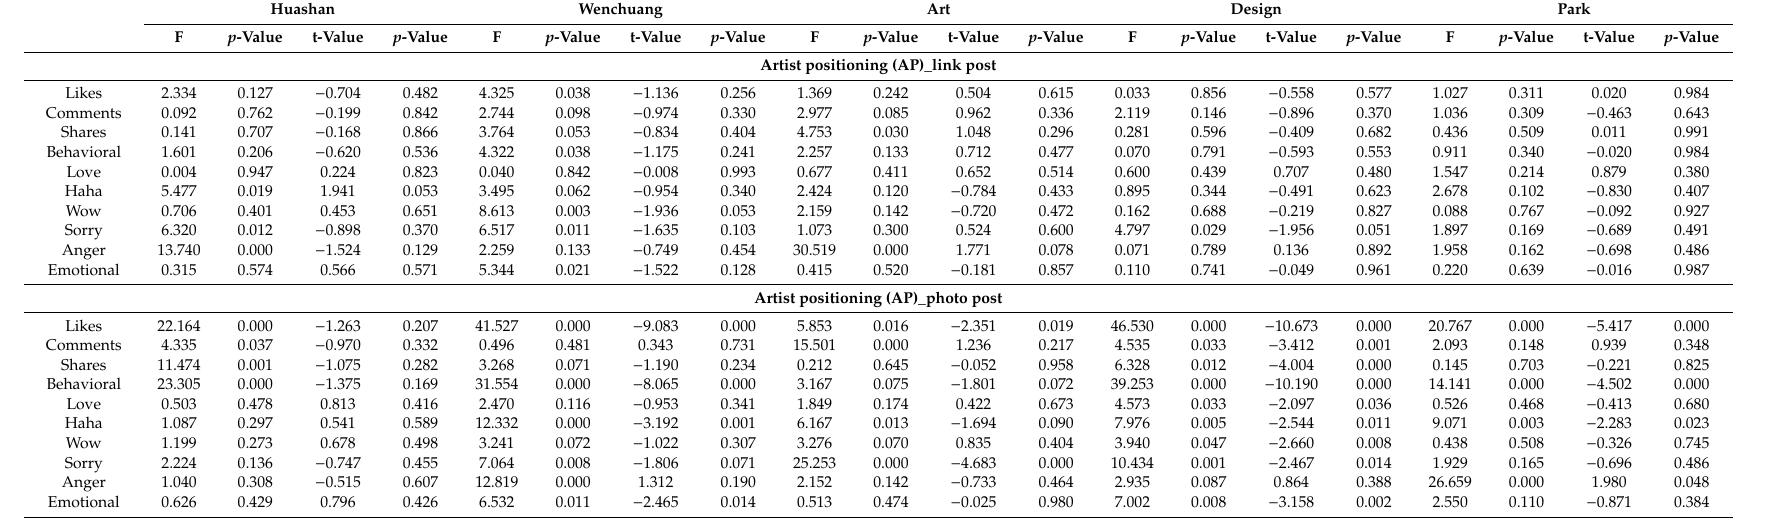
Table A2. The results of independent sample t test (artist positioning